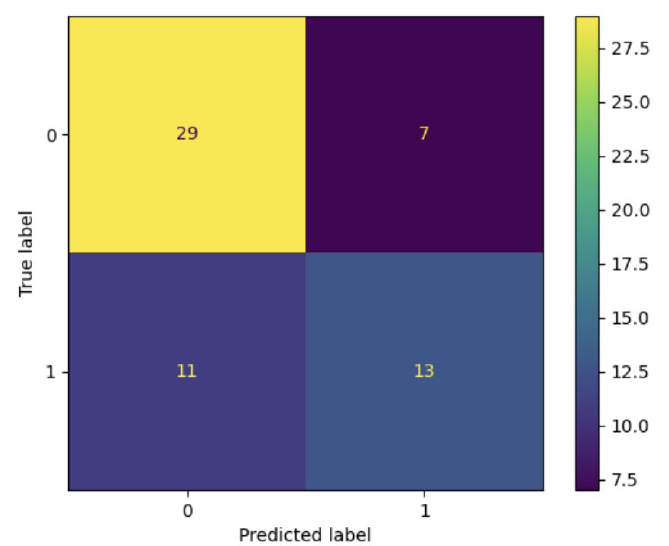
Figure 5. In the whole dataset ( n = 60), the logistic regression identified 29 true negative cases, 13 true positive cases, 11 false negative cases, and 7 false positives.